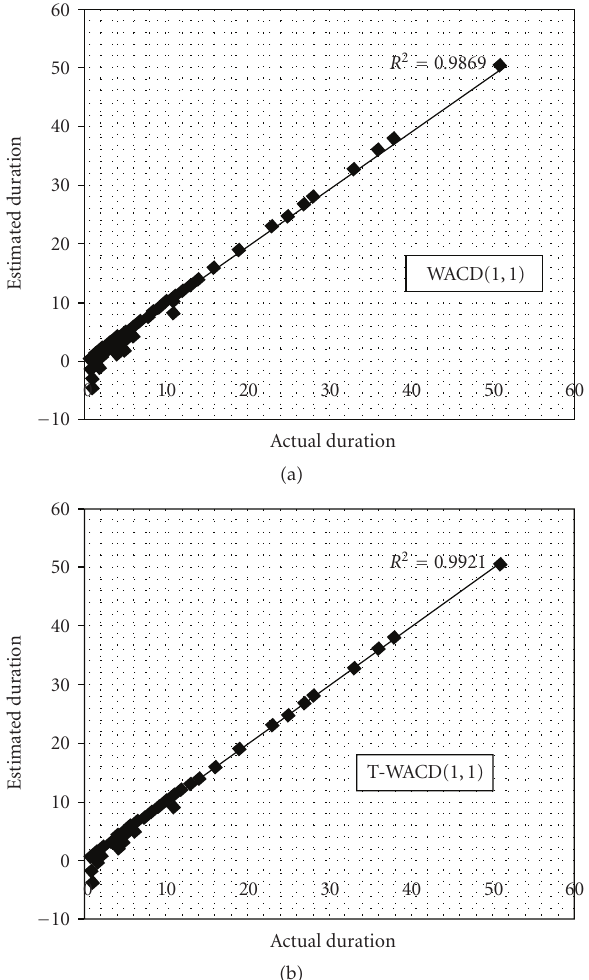
Figure 7: Actual versus estimated congestion durations for the WACD (cid:3) 1 , 1 (cid:4) and T-WACD (cid:3) 1 , 1 (cid:4) models.